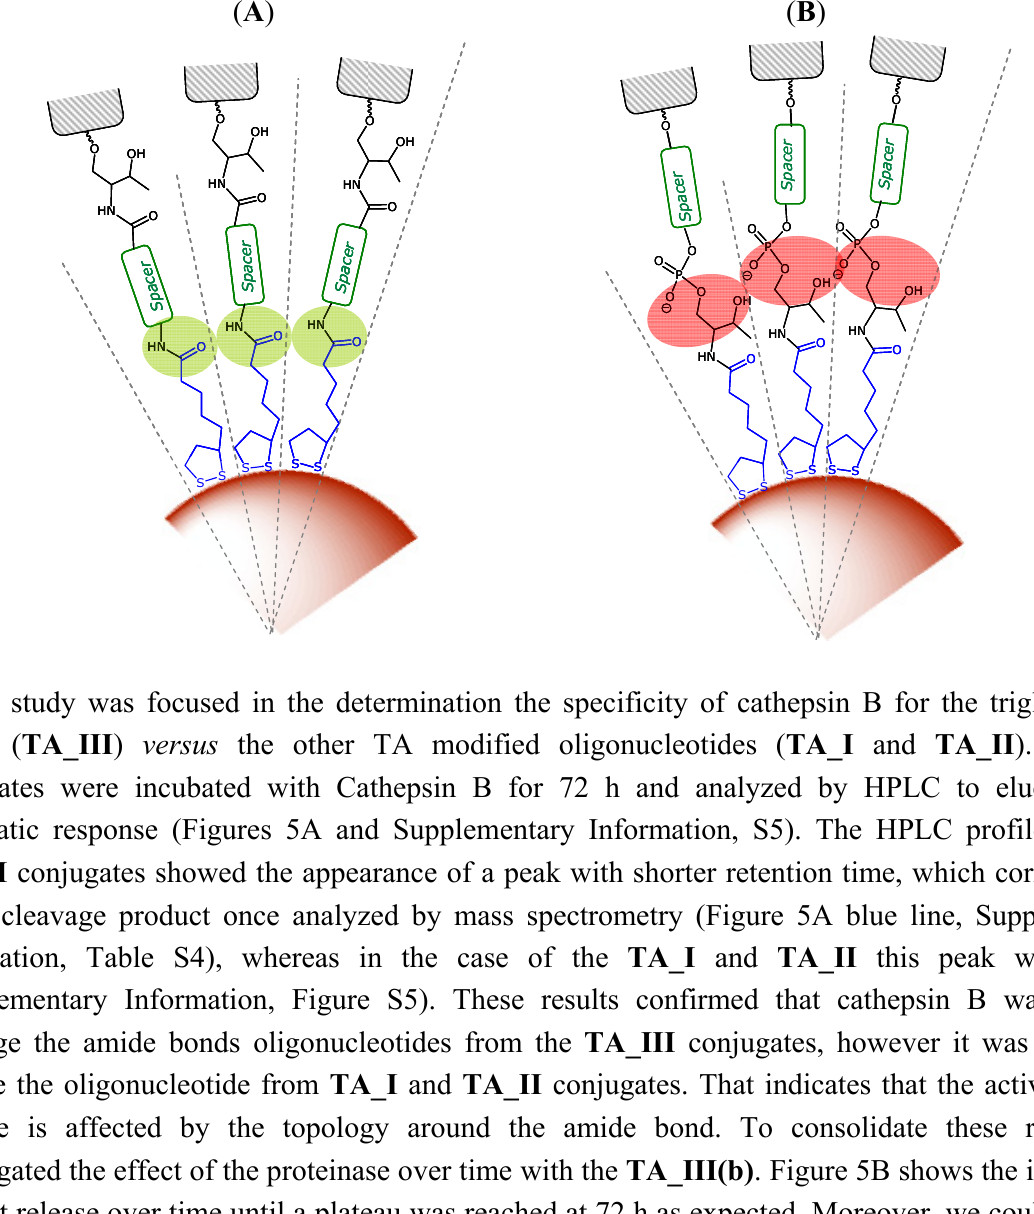
Figure 4. Scheme showing ( A ) favourable interactions (in green) between amide groups and ( B ) disfavourable interactions (in red) between bulky or negatively charged substituents. ( A ) ( B